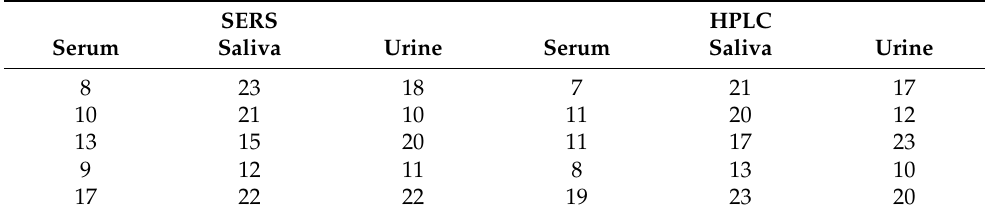
Table 2. SERS and HPLC methods for uric acid concentration detection ( µ g/mL). SERS HPLC